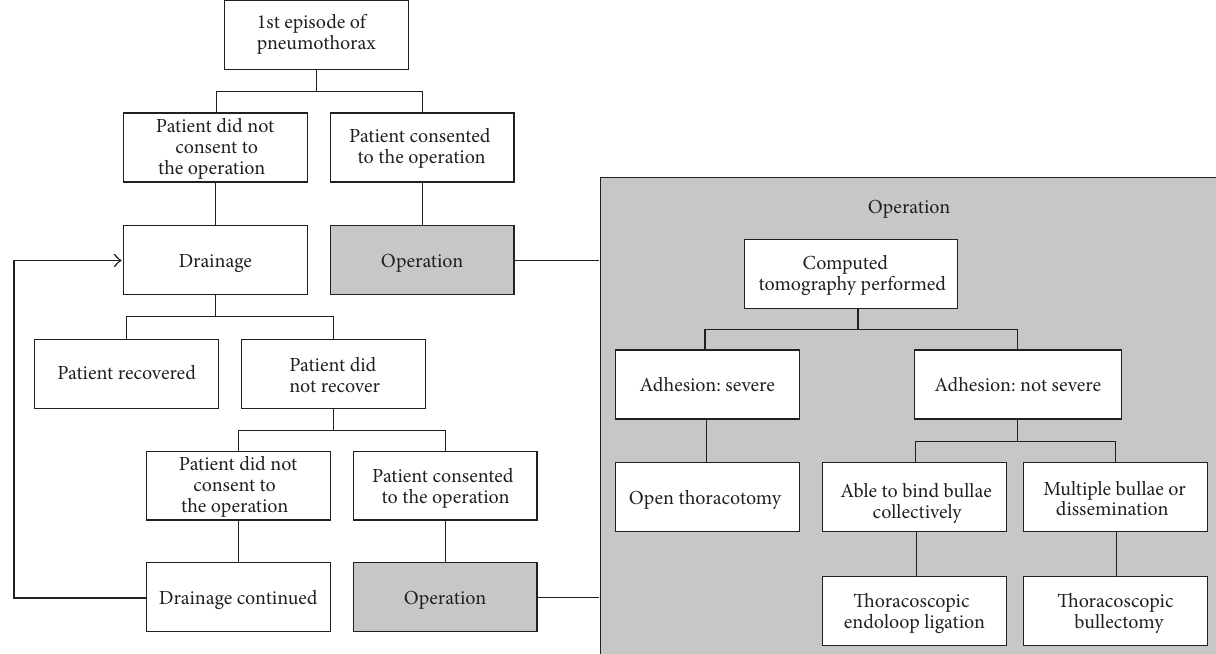
Figure 1: Decision schema for choosing the surgical procedure (CT: computed tomography; VATS: video-assisted thoracoscopic